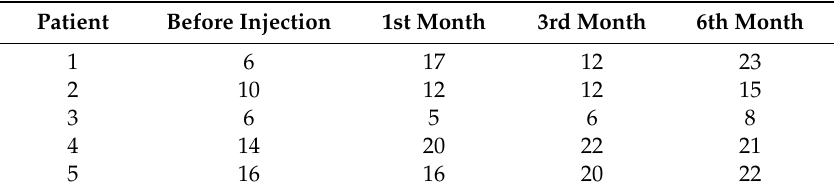
Table 3. IIEF-5 scores.